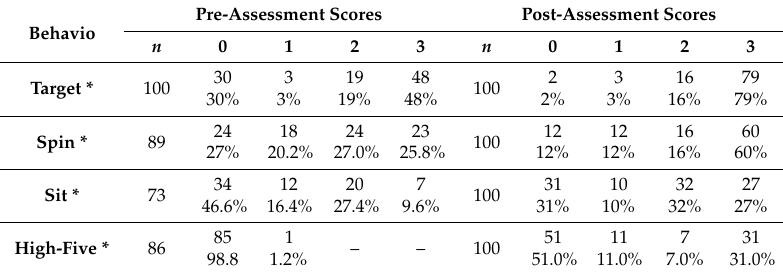
Table 3. Comparison of median pre-assessment and post-assessment scores for four taught behaviors in 100 cats *.